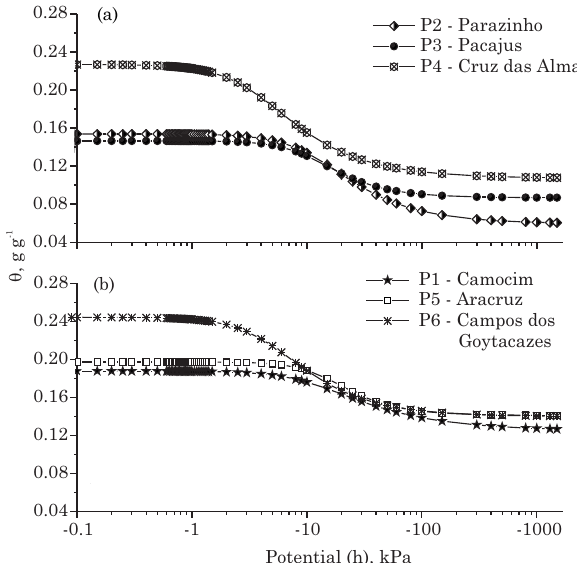
Figure 2. Water retention curve for hard-setting soils with sandy clay (a) and sandy clay loam (b) textures, at different locations of the Coastal Tablelands in Brazil.